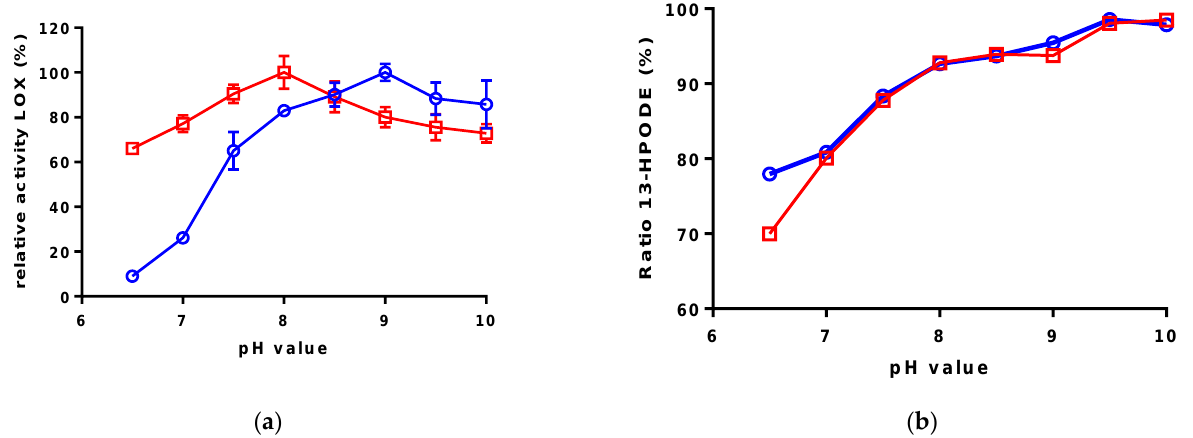
Figure 1. ( a ) Comparison of specific activities and ( b ) of regioselectivities at a linoleic acid concentration of 1 mM in dependence of pH-values with (cid:3) = soy flour suspension and = LOX-1 obtained from Sigma Aldrich (peak assignment of regioisomers is shown exemplarily in Figure S1).